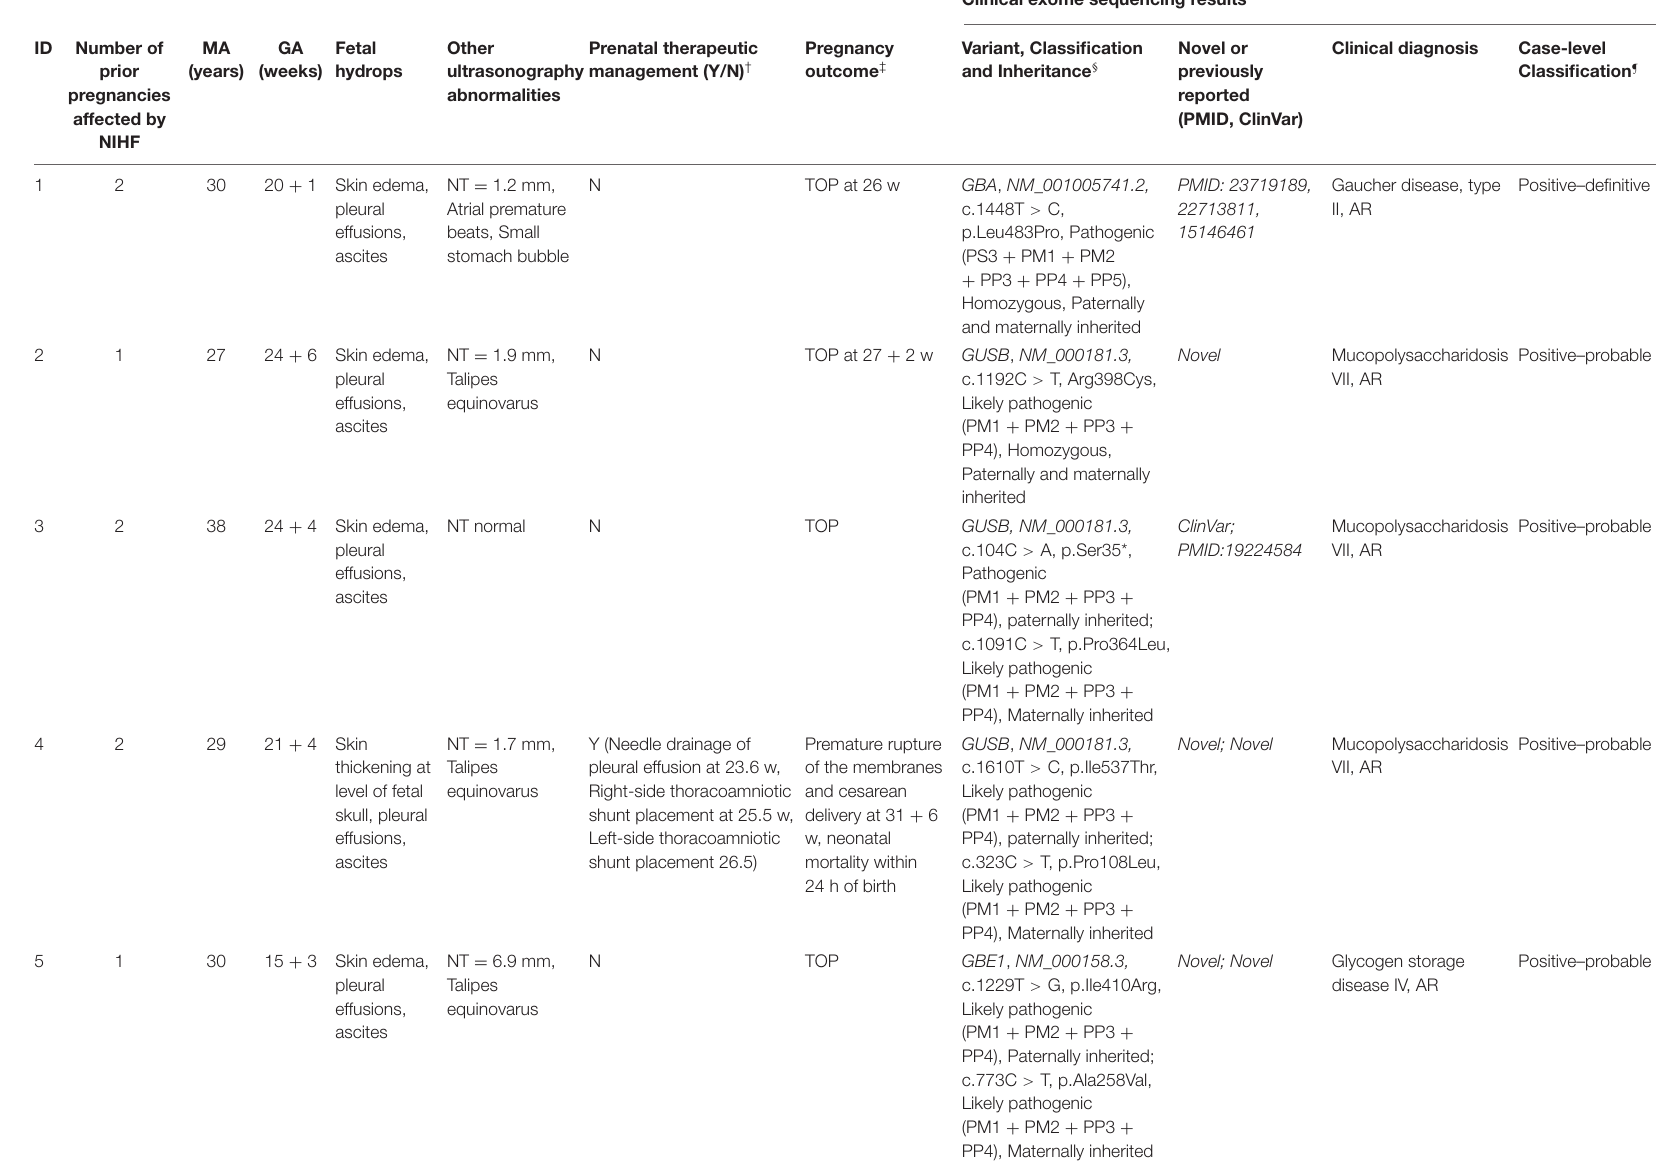
Clinical exome sequencing